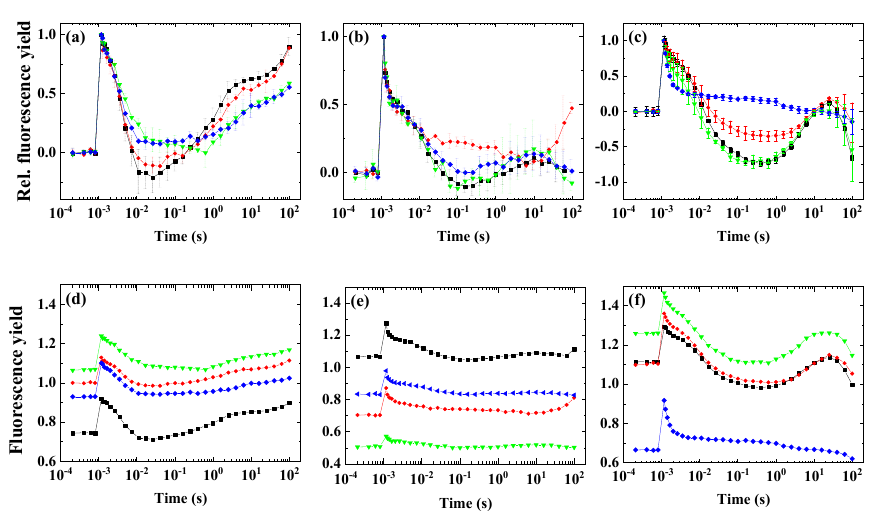
Figure 6. Effect of various inhibitors of cyclic electron flow on flash-induced Chl fluorescence relaxation in Dunaliella salina ( a , d ), Chlorella sorokiniana ( b , e ) and Haematococcus pluvialis red cells ( c , f ). Black squares: samples without additional inhibitor, red circles: treated cells incubated with 4 µ M Antimycin A, green triangles: 1.6 mM Polymyxin B, blue triangles: treated cells incubated with 15 µ M diphenyleneiodonium (DPI). Panels a , b and c show the double normalized fluorescence traces while panels d , e and f show the original traces without normalization. Error bars represent the standard deviation of the mean of three biological replicates.